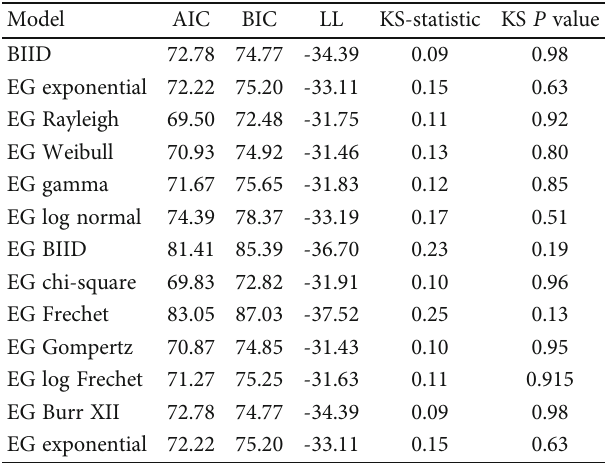
Table 15: Comparison of BIID with class of EGGDs using real dataset-1.